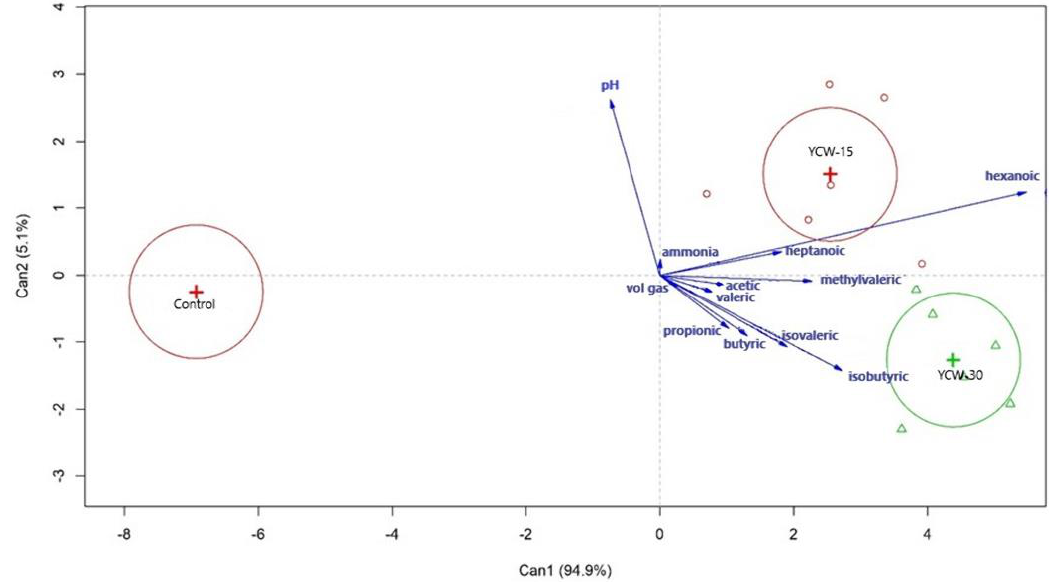
Figure 8. Principal component analysis biplot using first and second principal components (PC1, 94.9%; PC2, 5.1%). Treatments are located according to their coordinates in the components. Vectors relate the trends of variables to treatments.